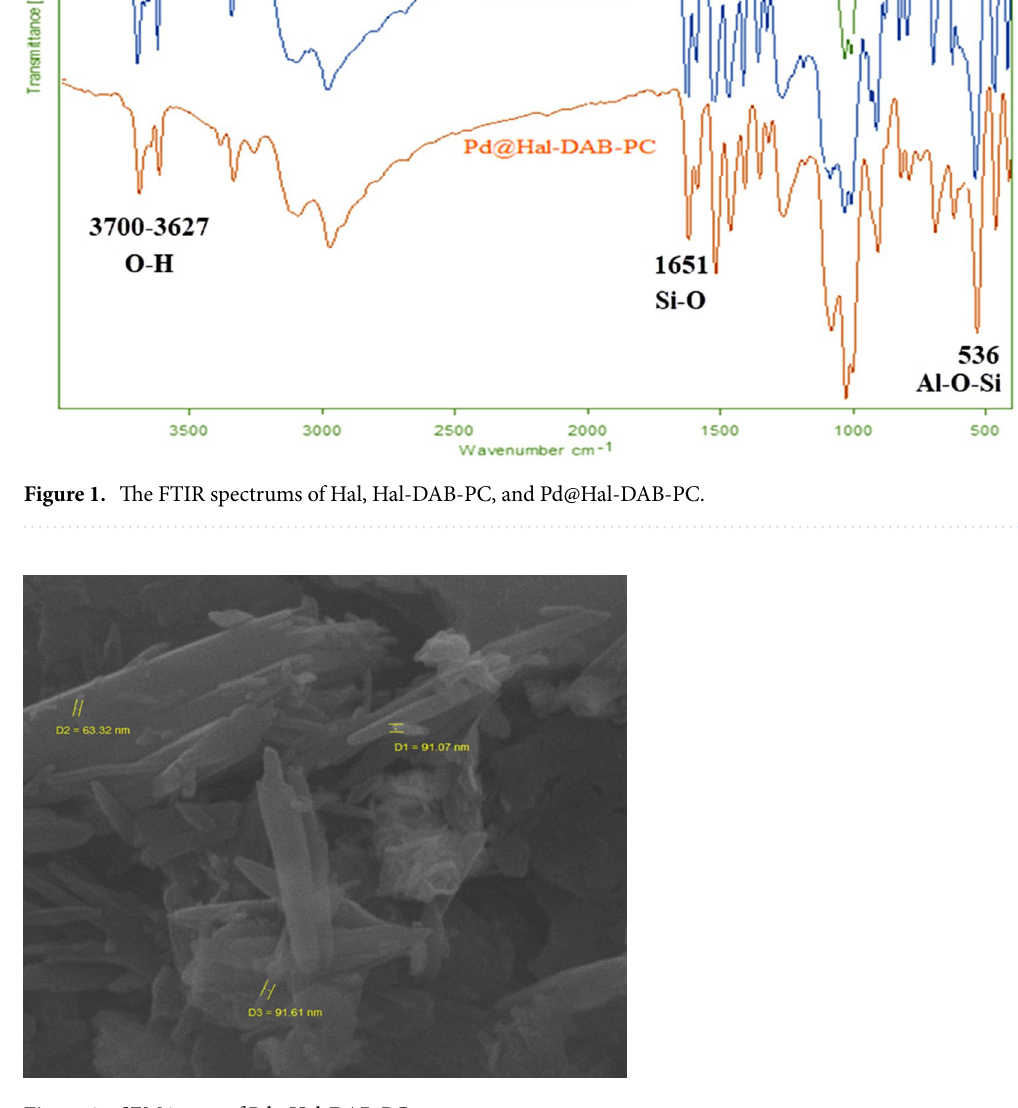
Figure 2. SEM image of